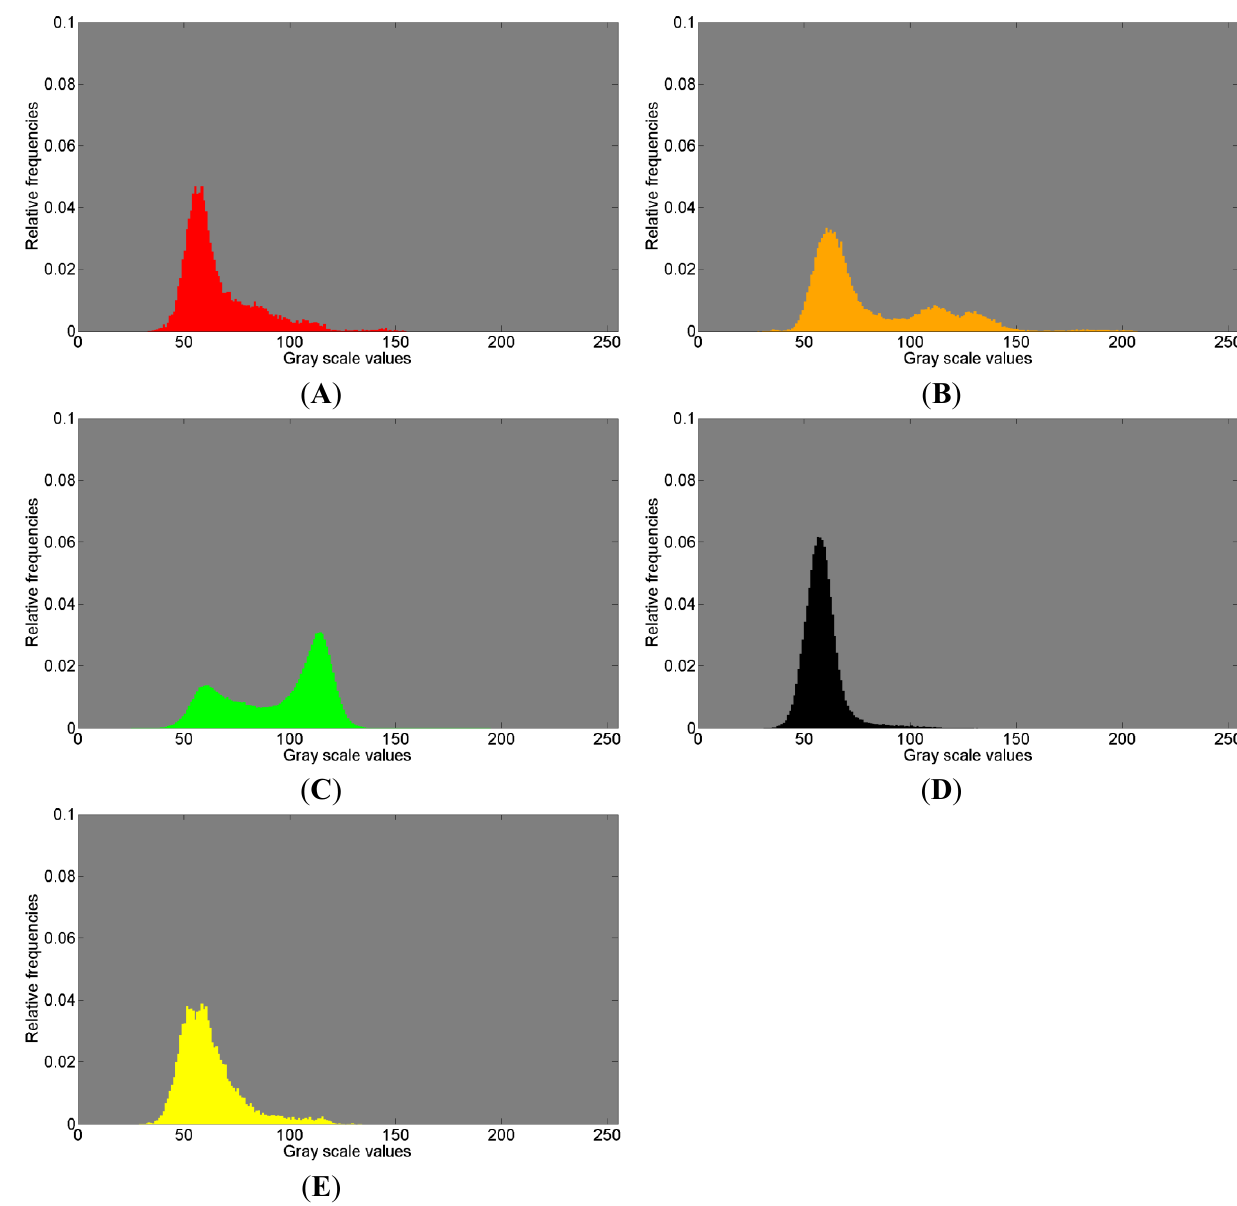
Figure 8. Histogram of gray scale values for ( A ) red; ( B ) orange; ( C ) green; ( D ) black; ( E ) yellow, shown in Figure 6A and in Figure 7A, associated with the first measurement (ROI 1) of the sinus grafted bone sample. See also Table 3 for the association of a color to a given material: red—Bio-Oss ® , orange—phosphate, green—pork bone, yellow—pork